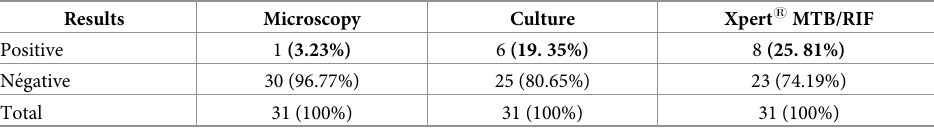
Table 2. Microscopy, cutlure and GeneXpert 1 MTB/RIF results in patients with active TB.